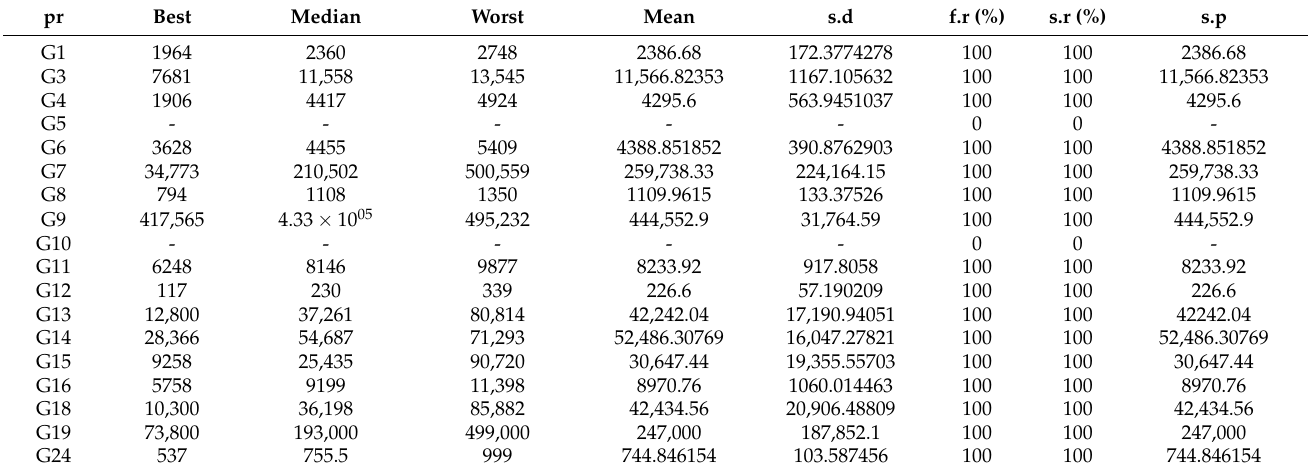
Table 5. Number of FES to achieve the fixed accuracy level (( f ( x ) − f ( x ∗ )) ≤ 0.0001 ) , success rate, feasible rate and success performance.